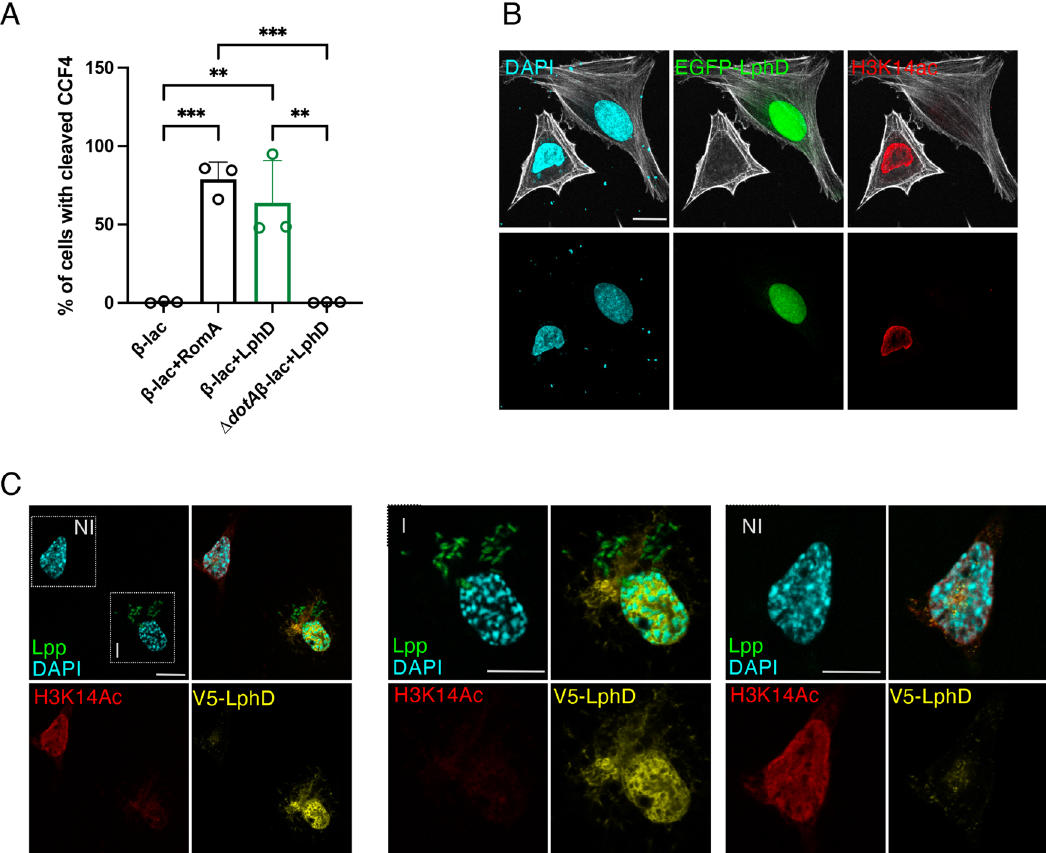
Fig. 2 | LphD is a secreted effector that targets H3K14 in the nucleus. A ß- lactamase secretion assays. Percentage of cells with cleaved CCF4 calculated as a ratio of secretion-positive (blue) over total stained cells (green and blue) after 2hours of infection with L. pneumophila (Lp ) wild-type (wt), or Δ dotA over- expressingeitherß-lactamase(ß-lac),ß-lacfusedtoLphD(ß-lac+LphD)ortoRomA (ß-lac+RomA). Data are presented as mean values ± SD of n =3 independent experiments. For statistical analyses an ordinary one-way ANOVA was performed using Tukey ’ s multiple comparisons test (** p =0.0032; *** p =0.0008). B Immuno fl uorescence analysis of EGFP-LphD and H3K14 acetylation. HeLa cells